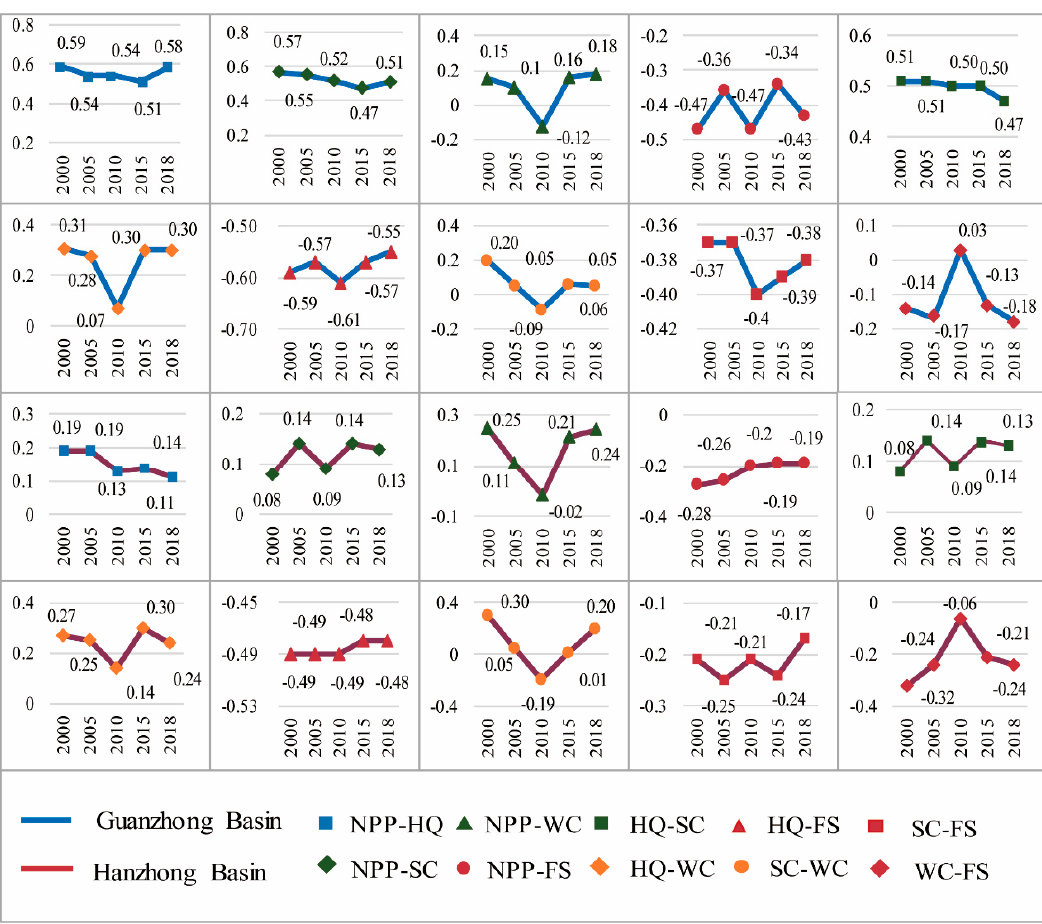
Figure 4. Spatial correlation coefficient for each pair of ecosystem services in two basins from 2000 to 2018.